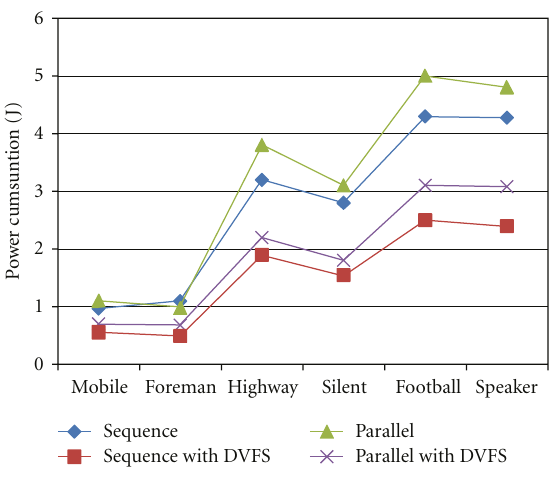
Figure 14: Power Cumsuntion.